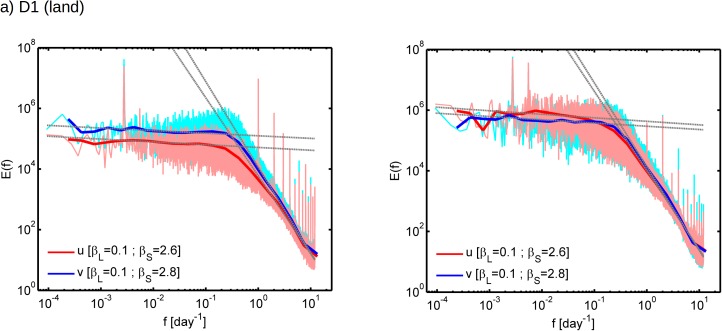
Ensemble Fourier power spectrum of CFSR hourly 10m wind speed computed over (a) D1 (land) and (b) D2 (ocean) sub-domains (see Fig 1). The pink lines represent the zonal wind component (u) and the red lines represent the respective logarithmic averaged spectrum. The light blue lines represent the meridional wind component (v) and the red line represents the respective logarithmic averaged spectrum. The dashed grey lines are the linear regression fits, with the corresponding slopes identified in the legend.